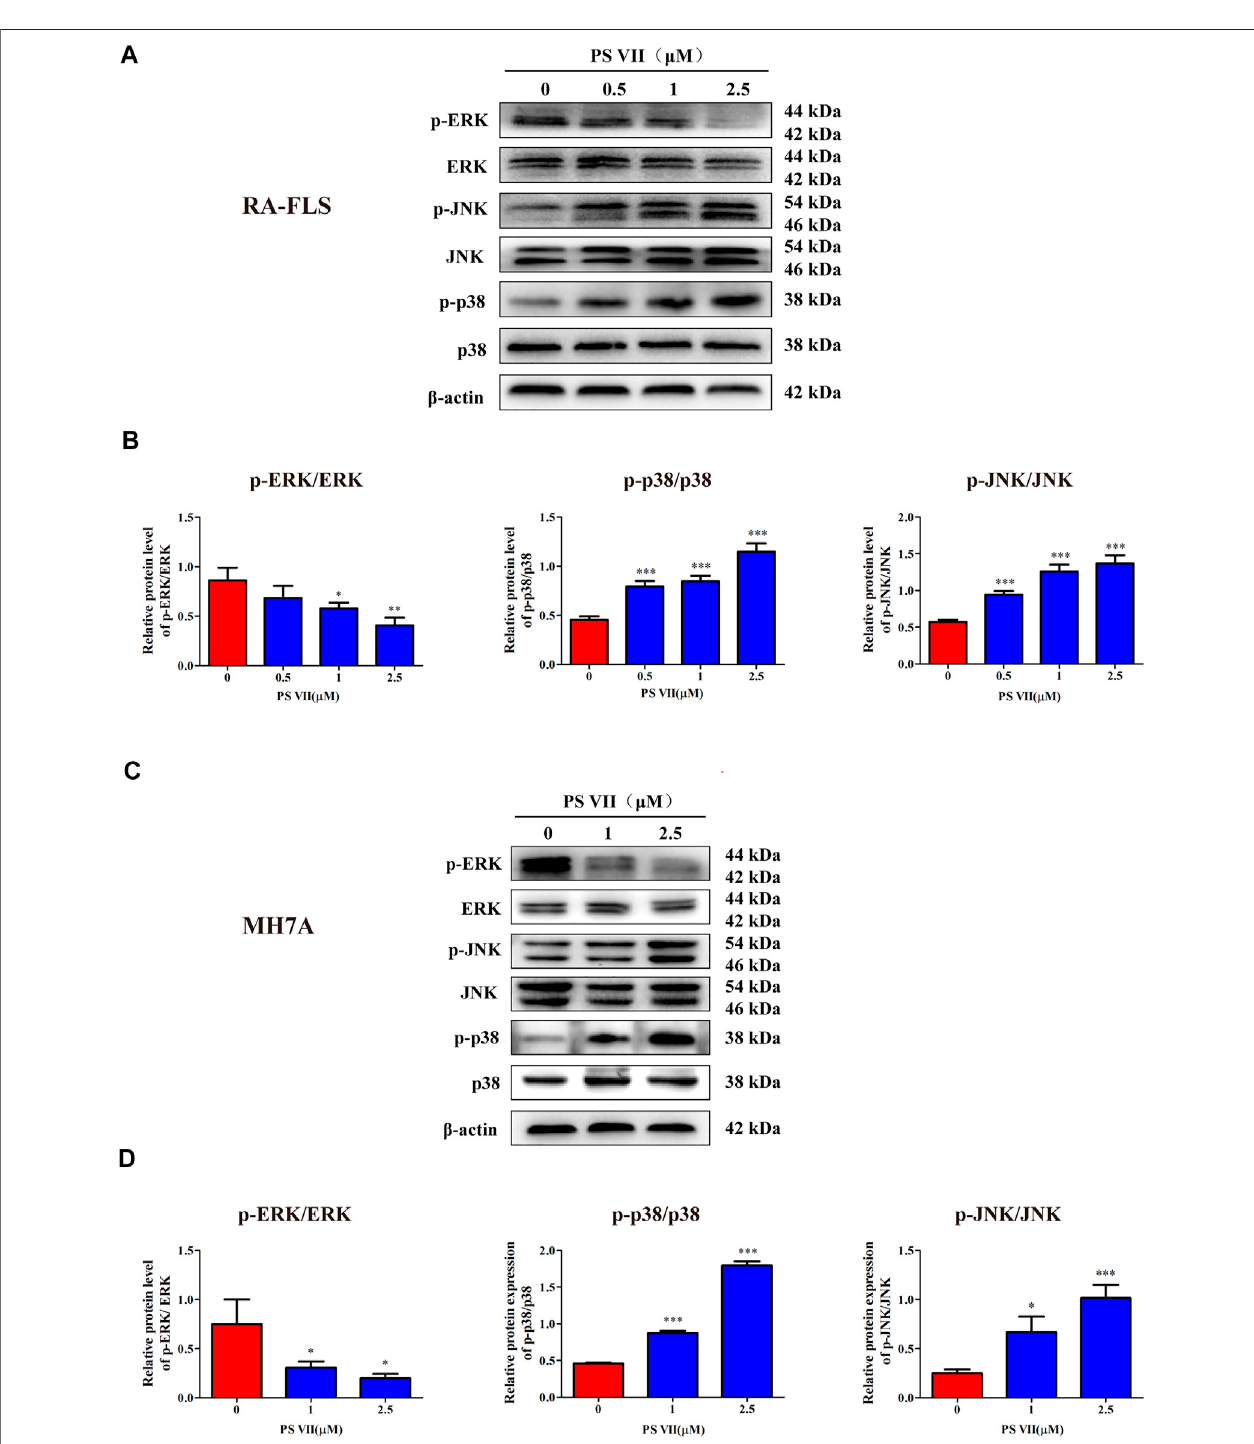
FIGURE 6 | Effects of PS VII on the MAPK pathway in RA-FLS and MH7A cells. Cells were treated with the indicated concentrations of PS VII for 48 h. The expression of p-ERK, ERK, p-JNK, JNK, p-p38 and p38 protein in RA-FLS (A) and MH7A (C) was detected by western blot analysis. (B, D) The relative expression of proteins in RA-FLS and MH7A cells was determined by optical density analysis. Image J was used to determine the density ratio of each phosphorylated MAPK band relative to total protein content. Compared with the control group, * p < 0.05, ** p < 0.01, *** p < 0.001.